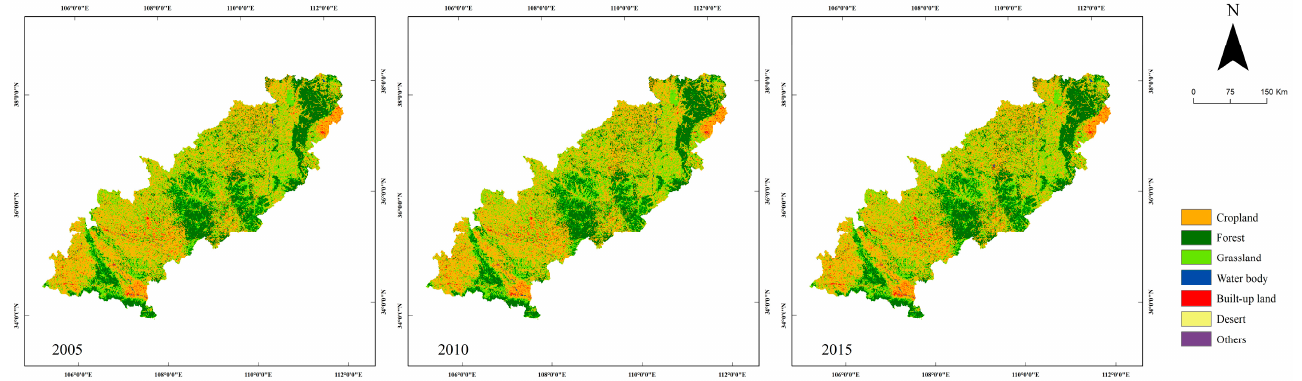
Figure 2. Spatial distribution of ecosystem in the Loess Plateau Ecological Screen in 2005, 2010, and 2015.